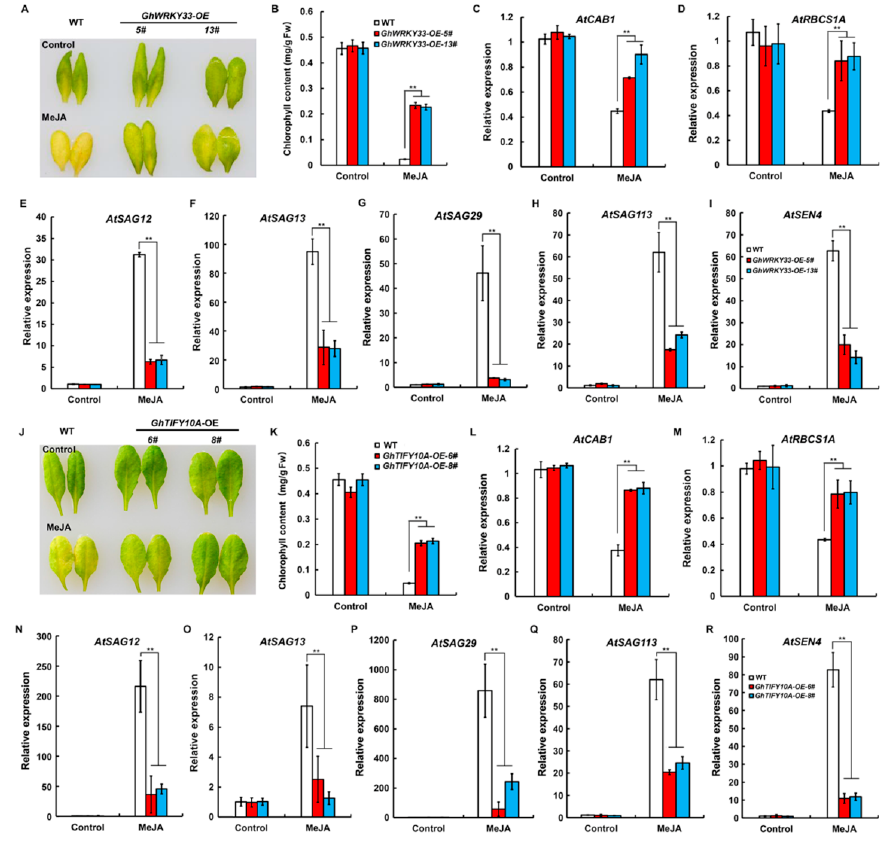
Figure 6. Both GhWRKY33 and GhTIFY10A delayed JA-induced leaf senescence. ( A , J ) Pheno- types of indicated genotypes. The wild-type leaves showed a more severe JA-induced senescence phenotype than both GhWRKY33 and GhTIFY10A overexpression lines upon 100 µ M MeJA treat- ment. ( B , K ) Chlorophyll content in detached full-grown rosette leaves of the indicated genotypes. ( C – I , L – R ) Transcript levels of AtSAGs, AtCAB1, and AtRBCS1A in the indicated genotypes. Date from three biological replicates were analyzed by ANOVA, and asterisks indicate significant differences compared with WT (** p <